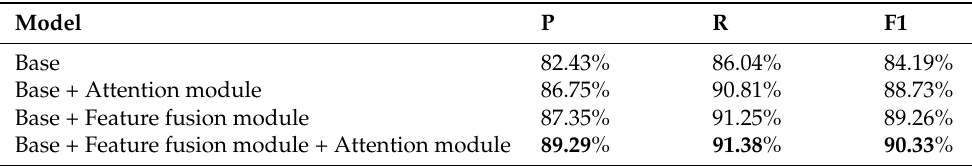
Table 9. Ablation experiments for each module on the SemEval-2010 Task8 dataset.